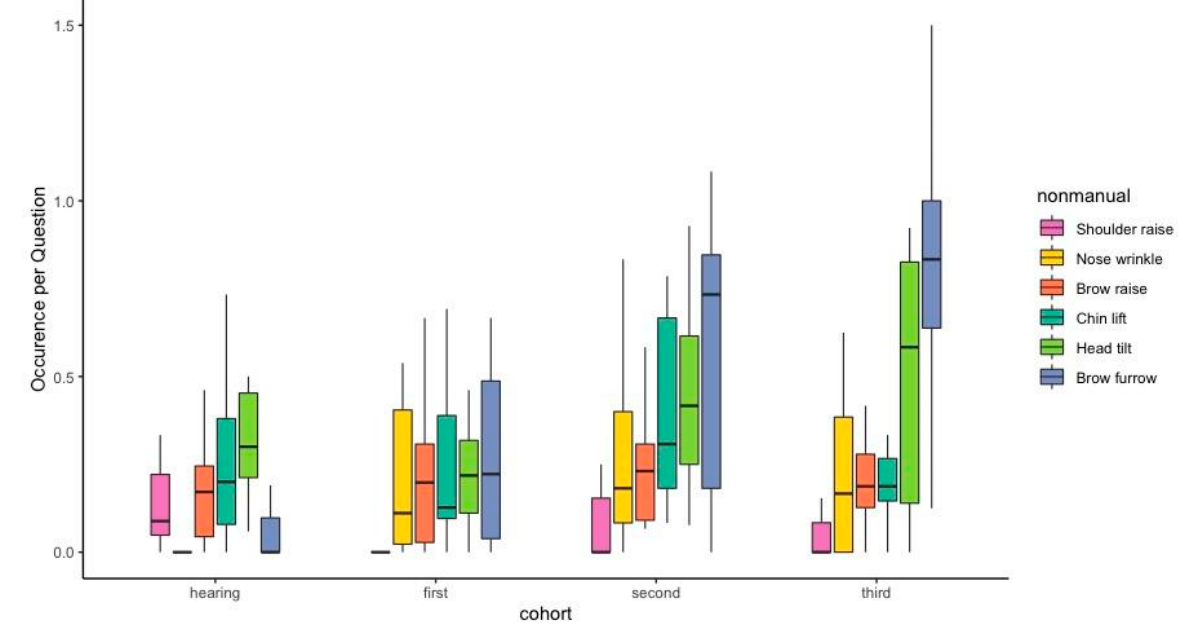
Figure 2. Average frequency each non-manual per question across cohorts. The black line indicates the median value for each non-manual type. Whiskers indicate the maximum and minimum values, excluding extreme outliers. Non-manuals are ordered according to mean frequency over all groups combined, with the more frequent to the right. Figure created using the ggplot2 package (Wickham 2016) in the R programming environment.